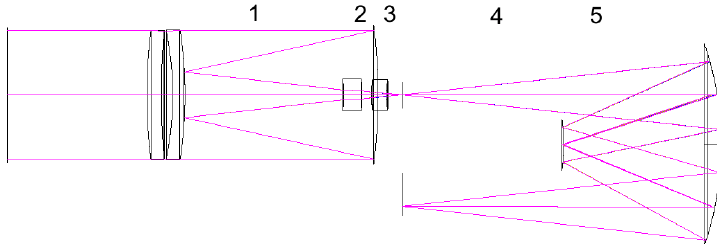
Figure 2. Essential segments of the optical scheme of the hyperspectrometer with an objective.